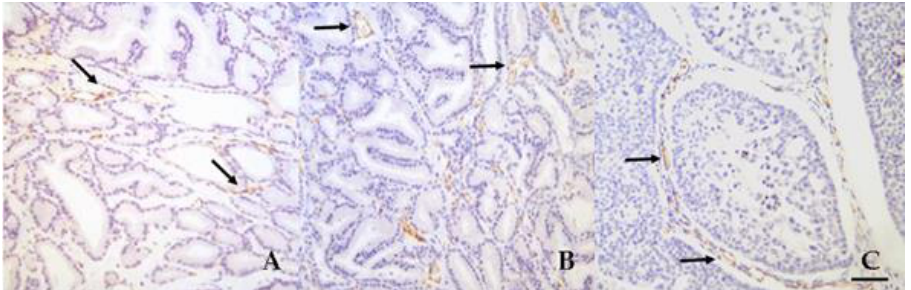
Figure 4. CD31-stained microvessels (indicated by arrows) in normal prostate tissue ( A ), benign prostate hyperplasia ( B ), and prostate carcinoma ( C ). Multiple, brown-stained microvessels are visible in intraglandular ( A – B ) and intratumoral ( C ) areas. Bar = 40 μm. Table 4. Microvessel density (MVD) in periglandular/peritumoral versus intraglandular/intratumoral areas based on CD31 immunostaining.